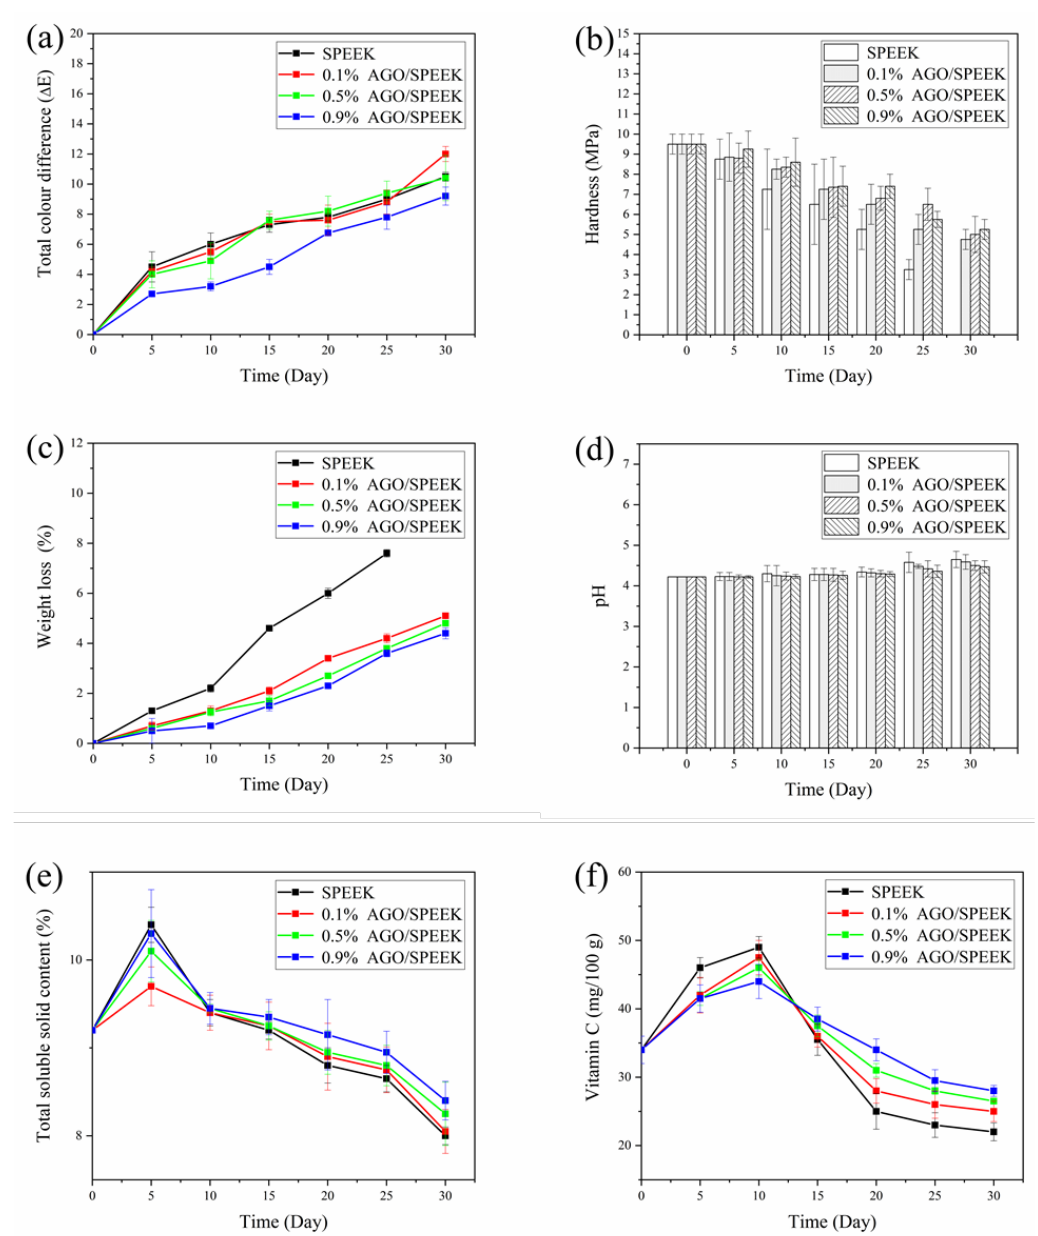
Figure 7. Physicochemical properties of AGO/SPEEK films in the storage of cherry tomatoes. ( a ) Total color difference, ( b ) hardness, ( c ) weight loss, ( d ) pH, ( e ) total soluble solid content, ( f ) vitamin